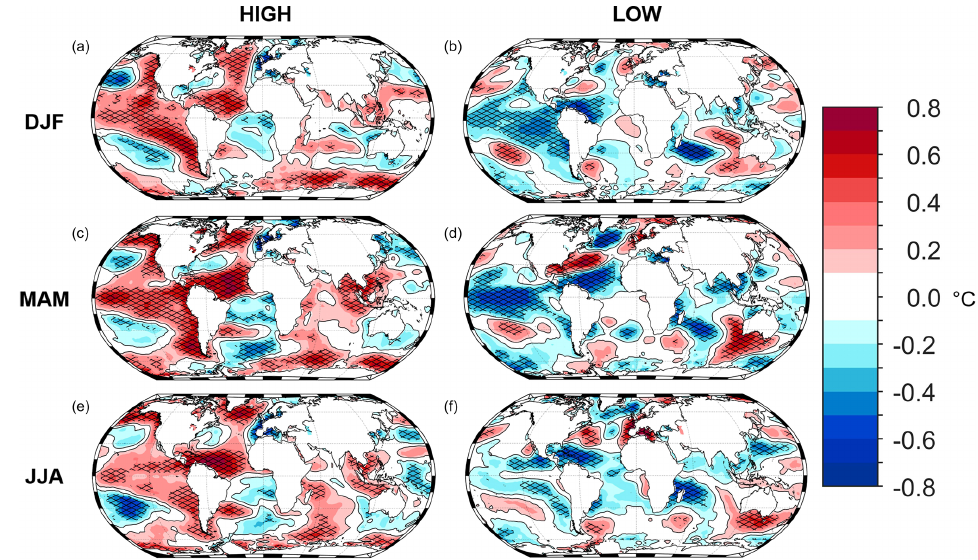
Figure 4. Composite maps (high and low) of SSTs related to the first δ 18 O component for the DJF, MAM, and JJA seasons. Panels (a) and (b) show the characteristics of the climate in DJF, panels (c) and (d) show the characteristics of the climate in MAM, and panels (e) and (f) show the characteristics of the climate in JJA. The results for maxima (a, c, e) and minima (b, d, f) events of PC1 are also given. The SSTs in winter, spring, and summer are characterized by ENSO activity. Furthermore, the significance is shown using a black grid overlay. The SST dataset from ERSST (Huang et al., 2017) is included in this figure for the period from 1854 to 2005.